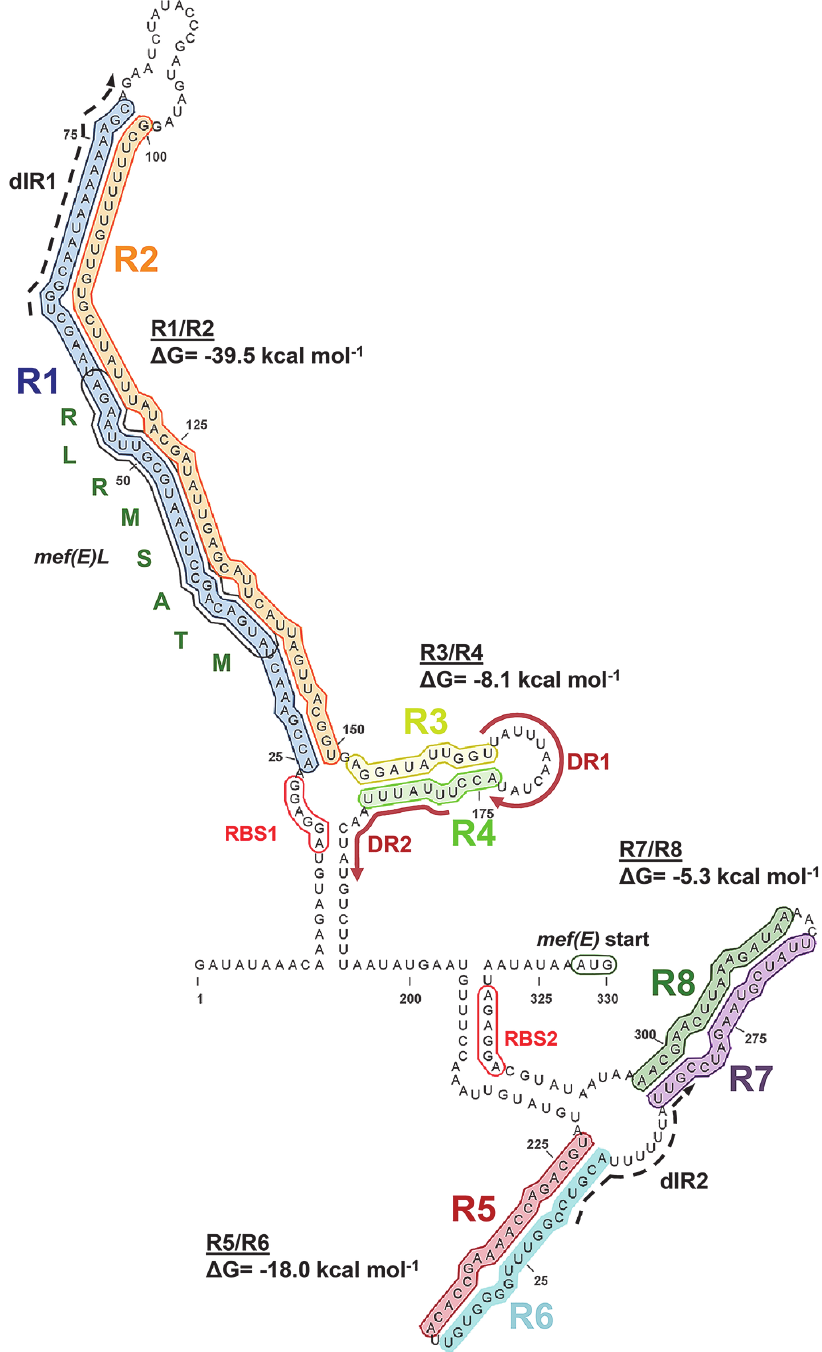
Fig 3. Structure of the mef(E)/mel 5 0 attenuator structure(transcriptionally inactive). The structure of the 327 nucleotide 5 0 mRNA region predicted by RNAFold and visualized with Visualization Applet for RNA (VARNA) [Version 3.8; [43]]. Inverted repeats are shaded with colors consistent with Fig. 1C. The amino acid sequence of the leader peptide Mef(E)L is indicated. The minimum free energy values from each stem-loop predicted by RNAFold analyses of the nucleotides involved in each duplex. Red arrows direct repeats. Dashed arrows, distal inverted repeats; RBS1, mef(E)L ribosomal binding site; RBS2 mef(E) ribosomal binding